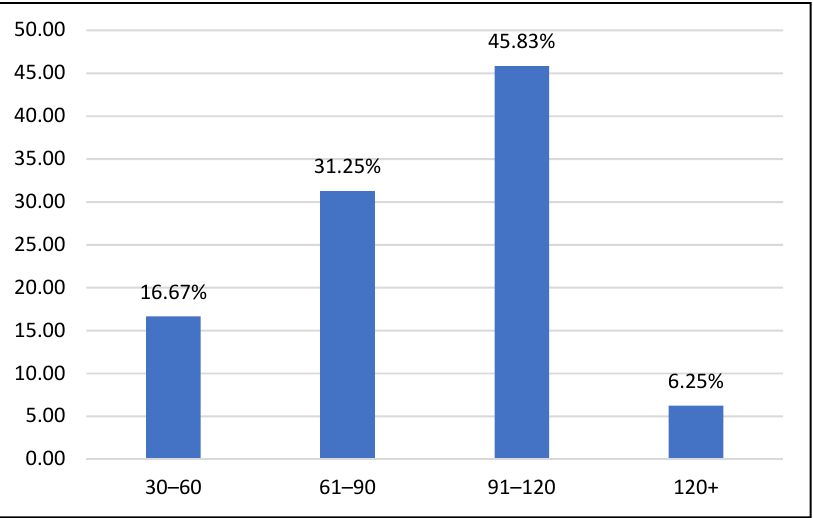
Figure 4. Distribution of total visit times across 30 min intervals.